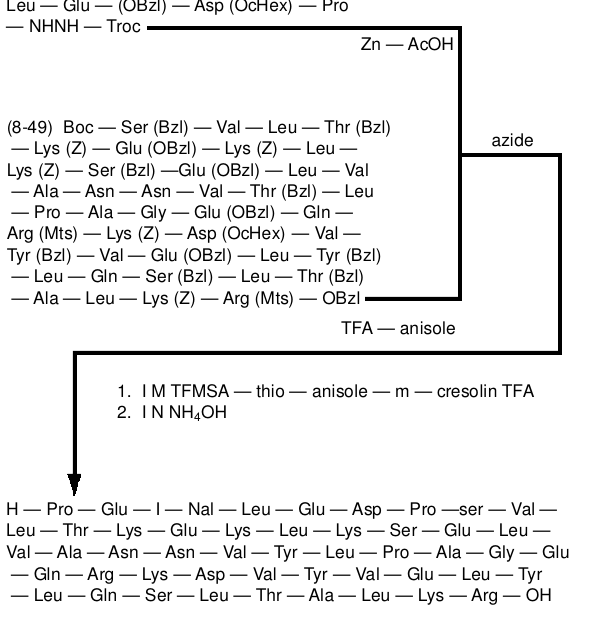
FIG. 1. Synthetic route to [l-Nal 3